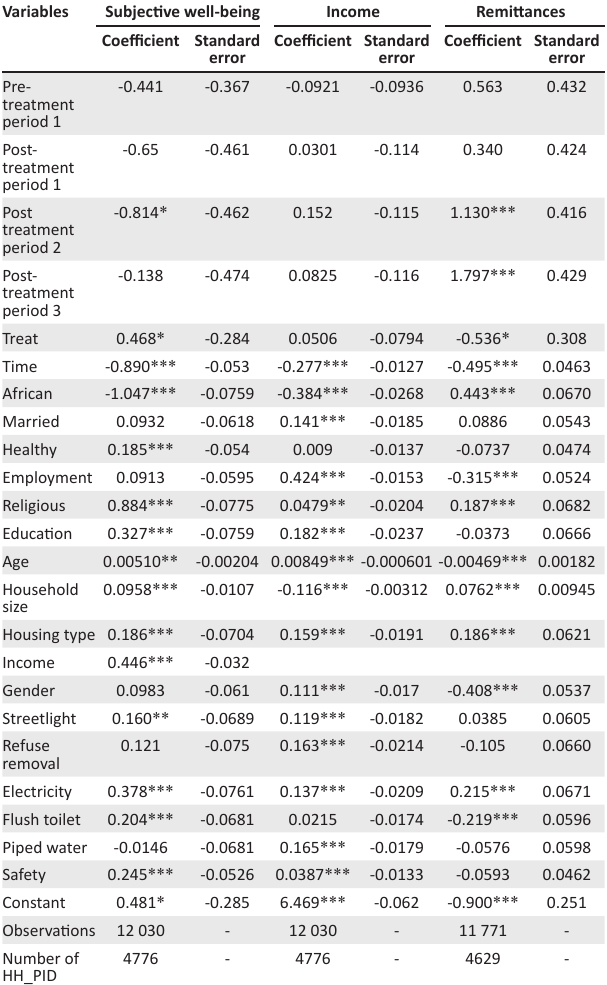
TABLE 4: Parallel trends test results. Variables Subjective well-being Income